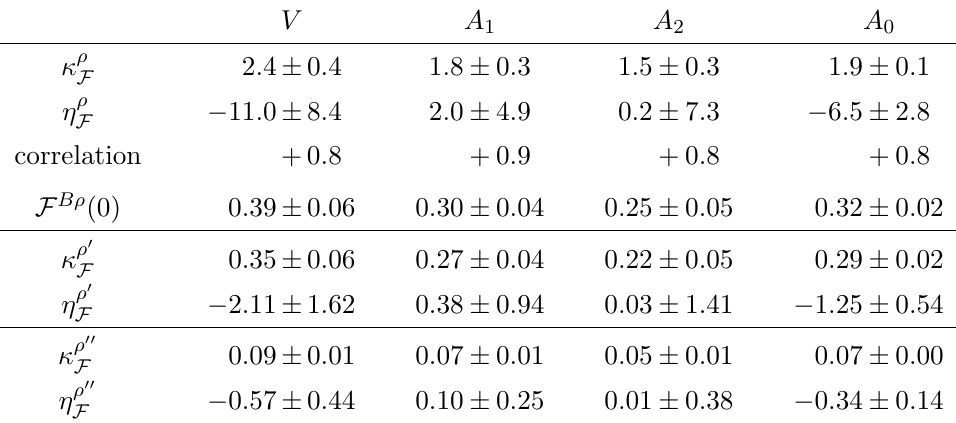
Table 3 . Results of the three-resonance